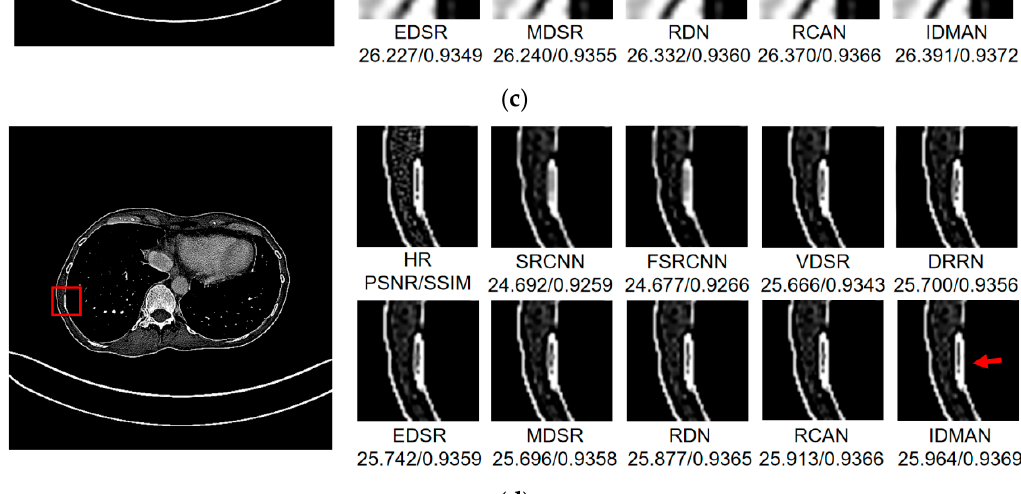
( a ) ( b ) Figure 9. Images ( a , b ) show the visual results of different algorithms on DeepLesion testing set for scaling factor × 3 .